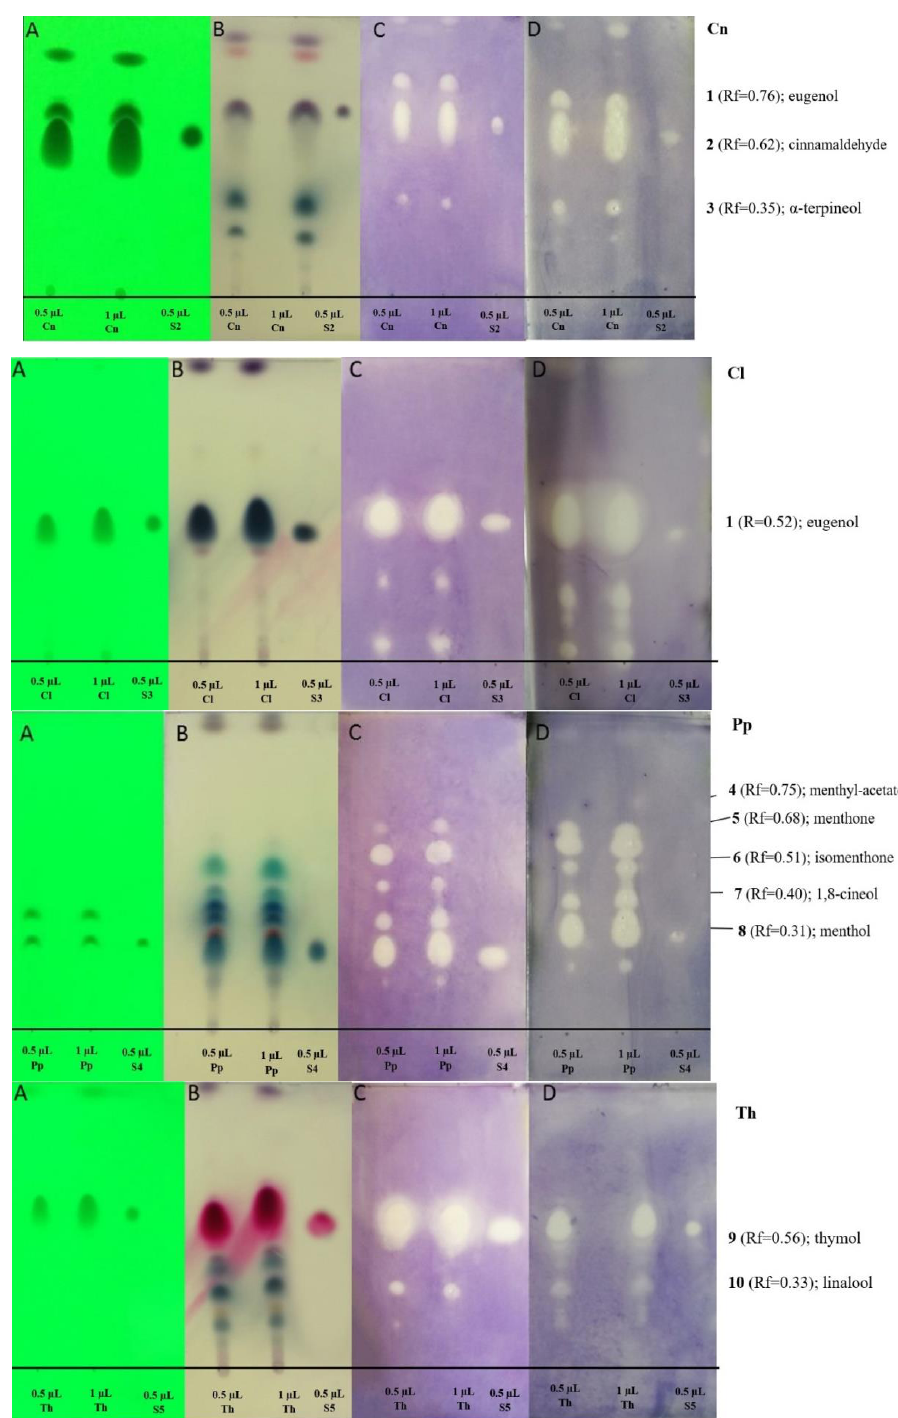
Figure 1. Antibacterial activity of essential oils (EOs) used in this study with direct bioautography (without TLC separation). The diameter of the inhibition zones was expressed in cm. Negative control — absolute ethanol; positive control — amikacin (equivalent to 0.05 mg antibiotic); 1 µL of EO sample (equivalent to 0.2 mg undiluted EO) was applied. Error bars represent S.E.M. Lowercase letters ( a – i ) show pairwise comparison based on Tukey post-hoc test, p < 0.05.